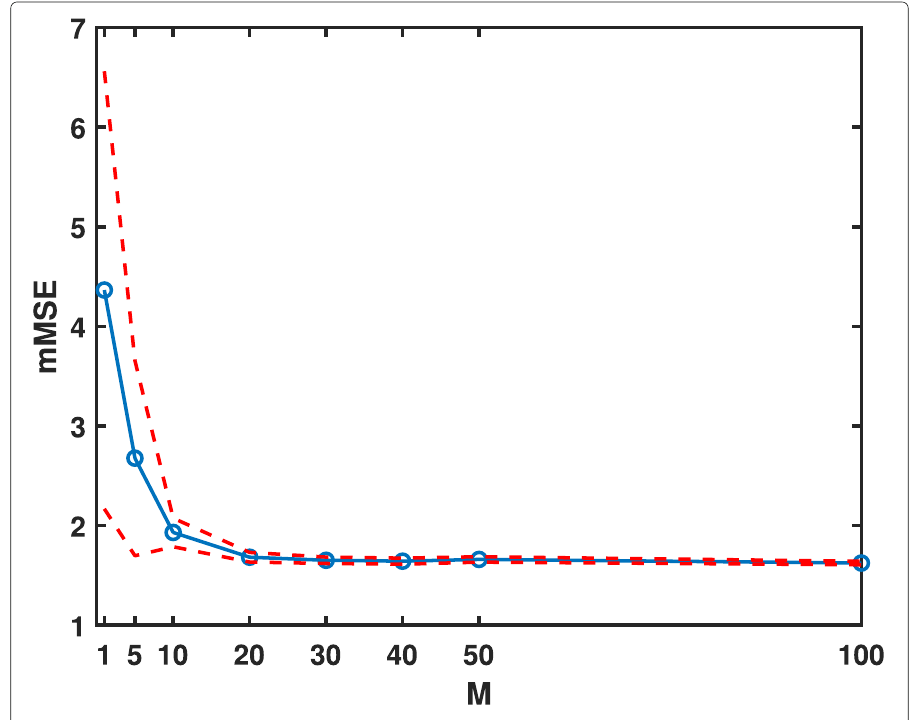
Fig. 5 The mMSE for LSP-HATS as function of the number of realizations used to produce the model parameter estimates with HATS. Red lines are 95% confidence intervals